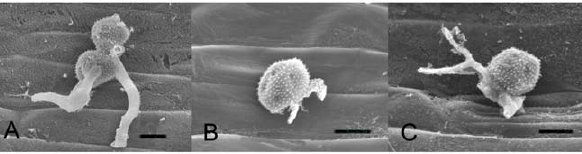
Figure 8. SEM photograph of germinated Pst urediospores after HIGS at 16 dpi. New urediospores of silenced PsCNA1/PsCNB1 of Pst CYR31 in wheat leaves after 6 hour mist moisture. SEM micrographs for A: BSMV: c :0-as (empty viral vector control), 1500 6 ; B: BSMV: c : PsCNA1 -as (silencing PsCNA1 ), 2000 6 ; C: BSMV: c : PsCNB1 -as (silencing PsCNB1 ), 2000 6 . Scale bars: 10 m m.